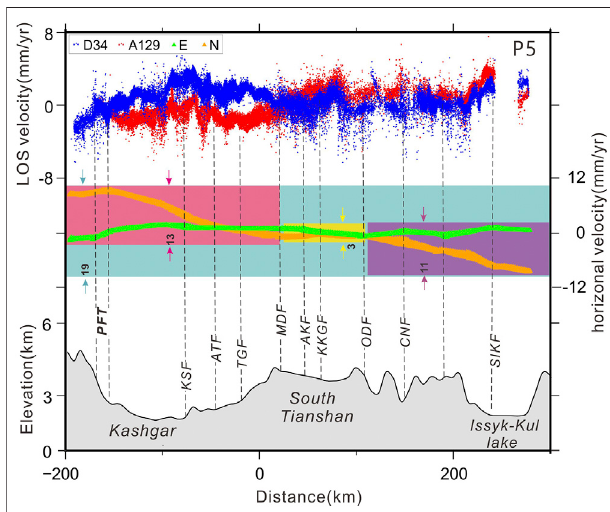
FIGURE 8 | Deformation data pro fi le across the South Tianshan. See Figures 2 , 3 for location.